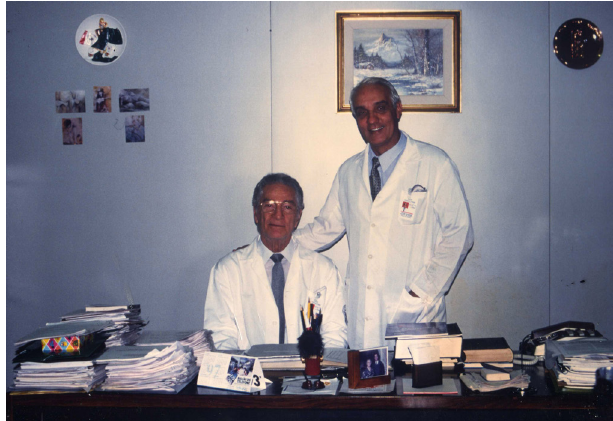
Fig. 4 - Prof. Verginelli, retired, in his room at Incor, receiving a visit from Full Professor and Chief of the Cardiovascular Surgery 284 Braz J Cardiovasc Surg | Rev Bras Cir Cardiovasc